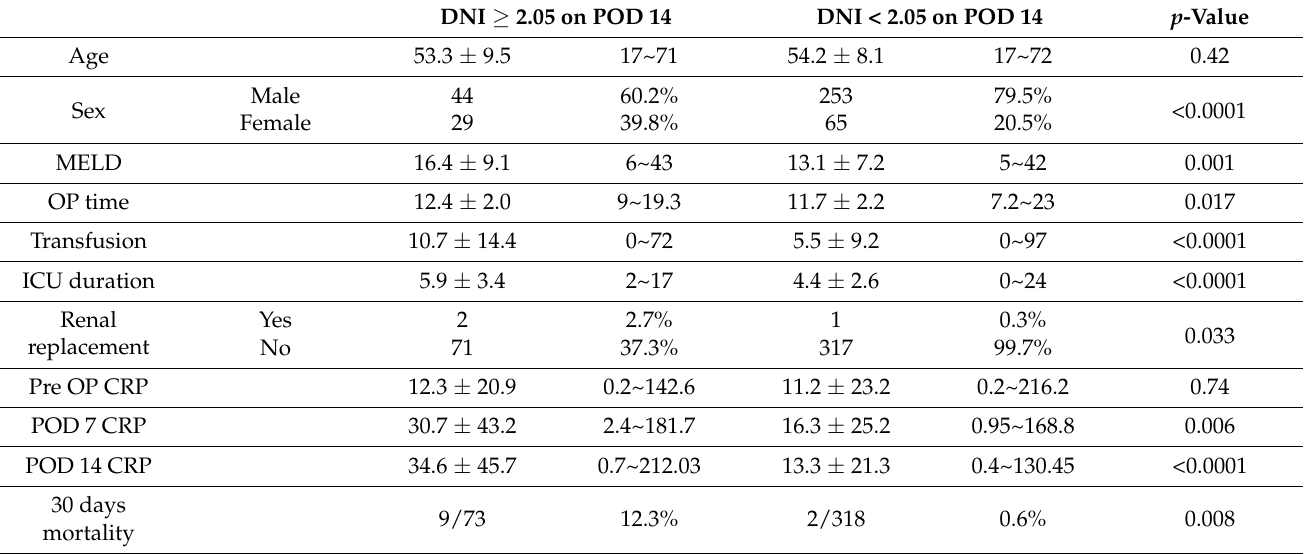
Table 2. The comparison of 30 days mortality according to the DNI level at POD 14 with a cut-off value of 2.05.